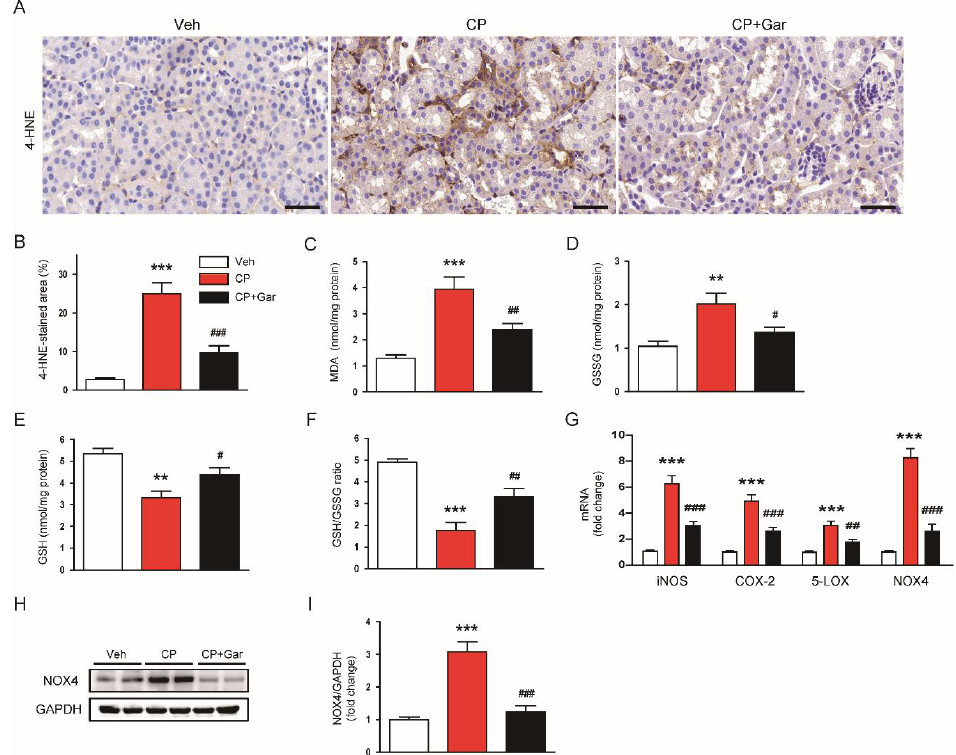
Figure 3. Effect of garcinol on oxidative stress and expression of pro-oxidant enzymes in cisplatin-injected mice. ( A ) Immunohistochemical staining of kidney tissues for 4-hydroxynonenal (4-HNE). Scale bar = 50 μm. ( B ) Percentage of stained areas for 4-HNE. ( C ) Malondialdehyde (MDA) levels. ( D ) Oxidized glutathione (GSSG) levels. ( E ) Reduced glutathione (GSH) levels ( F ) GSH/GSSG ratio. ( G ) The mRNA expression of inducible nitric oxide synthase (iNOS), cyclooxygenase-2 (COX-2), 5-lipoxygenase (5-LOX), and nicotinamide adenine dinucleotide phosphate oxidase 4 (NOX4). ( H ) Immunoblotting of NOX4. ( I ) Quantification of immunoblot for NOX4. n = 8 per group. ** p < 0.01 and *** p < 0.001 vs. Veh. # p < 0.05, ## p < 0.01, and ### p < 0.001 vs. CP.